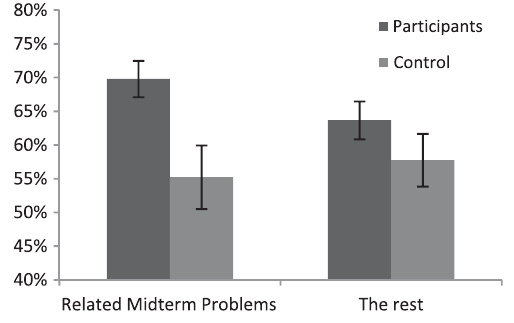
FIG. 5. Performance on the second midterm categorized by similarity to the practice exam.